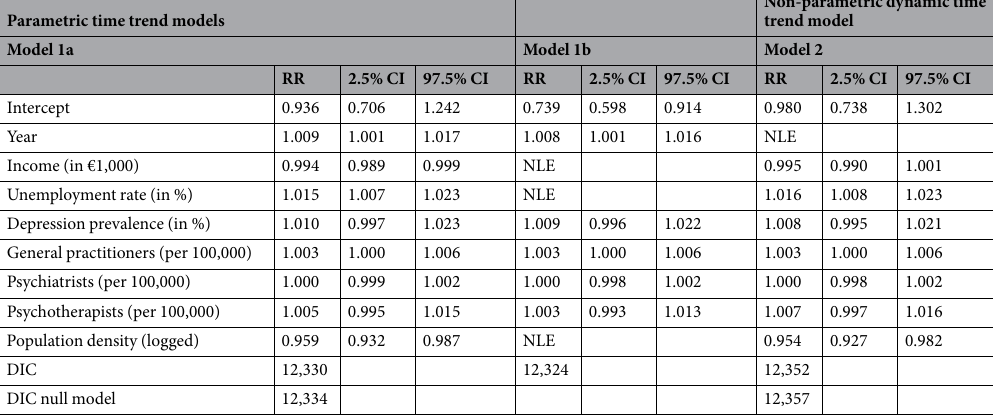
Table 1. Results of spatiotemporal regressions. Note: NLE = estimated as non-linear effect, RR = relative risk, CI = credibility